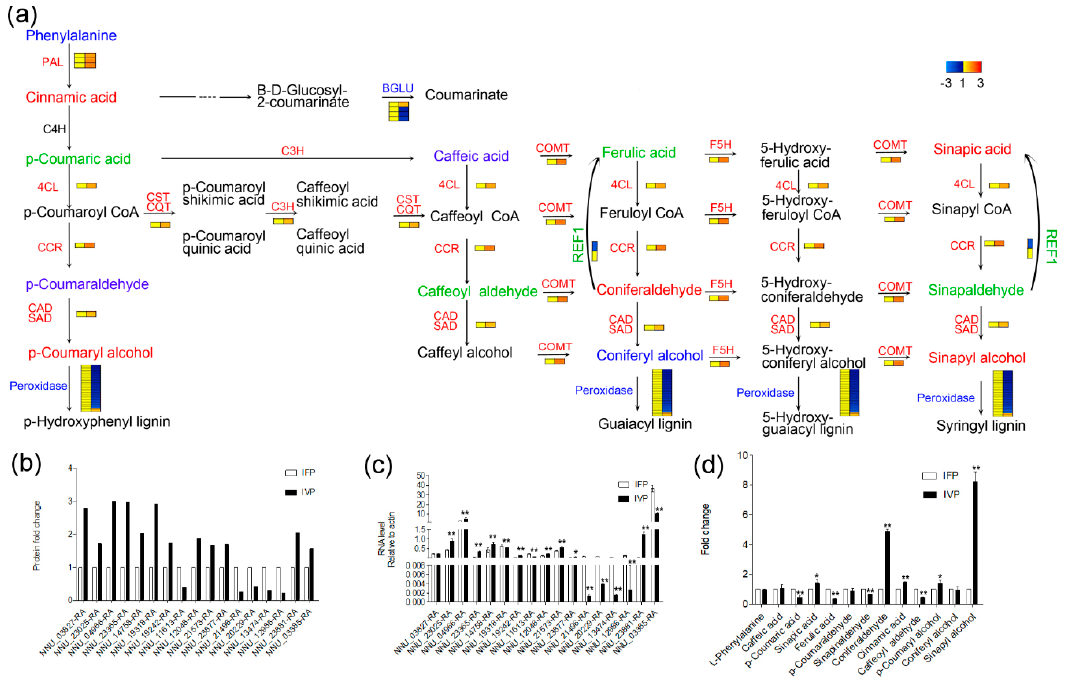
Figure 7. Overview of lignin biosynthesis pathway on transcription level, translation level and metabolite level. ( a ) Substrate, product and enzymes in whole pathway are written in red, green, blue and black color. Red color means abundance of substrate, product or enzymes were higher in IVP than IFP, green color means abundance of substrate, product or enzymes were higher in IFP than IVP and blue color means abundance of substrate and product were similar in two petioles or enzymes which catalyze same action show opposite abundance between IVP and IFP. Color bar shows changes in abundance of enzymes which were quantified in proteomics; ( b , c ) abundance of selected enzymes in lignin biosynthesis pathway and mRNA expression level of genes encoding selected enzymes in lignin biosynthesis pathway; ( d ) abundance of metabolites in lignin biosynthesis pathway. Data are means ± SD from 3 independent biologic repeats. Asterisks and double asterisks indicate significant changes compared to control as assessed according to Student’s t -test (* p < 0.05 and ** p < 0.01).